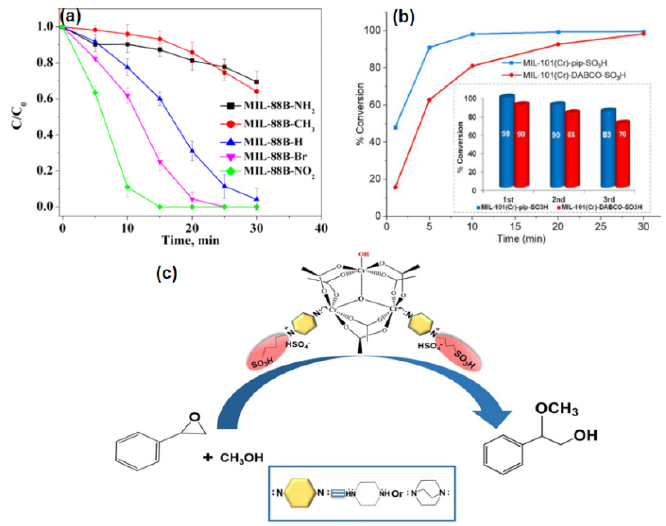
Figure 8. ( a ) Time profiles of phenol degradation during MIL-88B(Fe)-X catalysis. Fenton-like reaction [62]; ( b ) Kinetic profiles of the methanolysis of styrene oxide [63]; and ( c ) Mechanism for MIL-pip-SO 3 H and MIL-DABCO-SO 3 H [63].